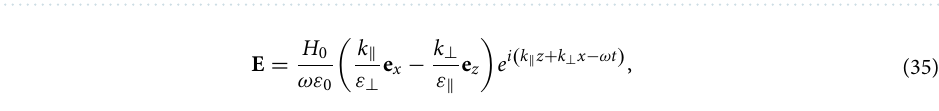
ε SiO 3.9 . For the other parameters we consider 2 = = 0 and k 0 � = ⊥ =